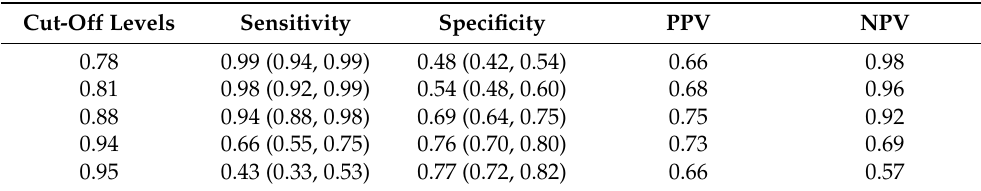
Table 3. Diagnostic test accuracy of volatile organic compounds for the detection of a high- risk